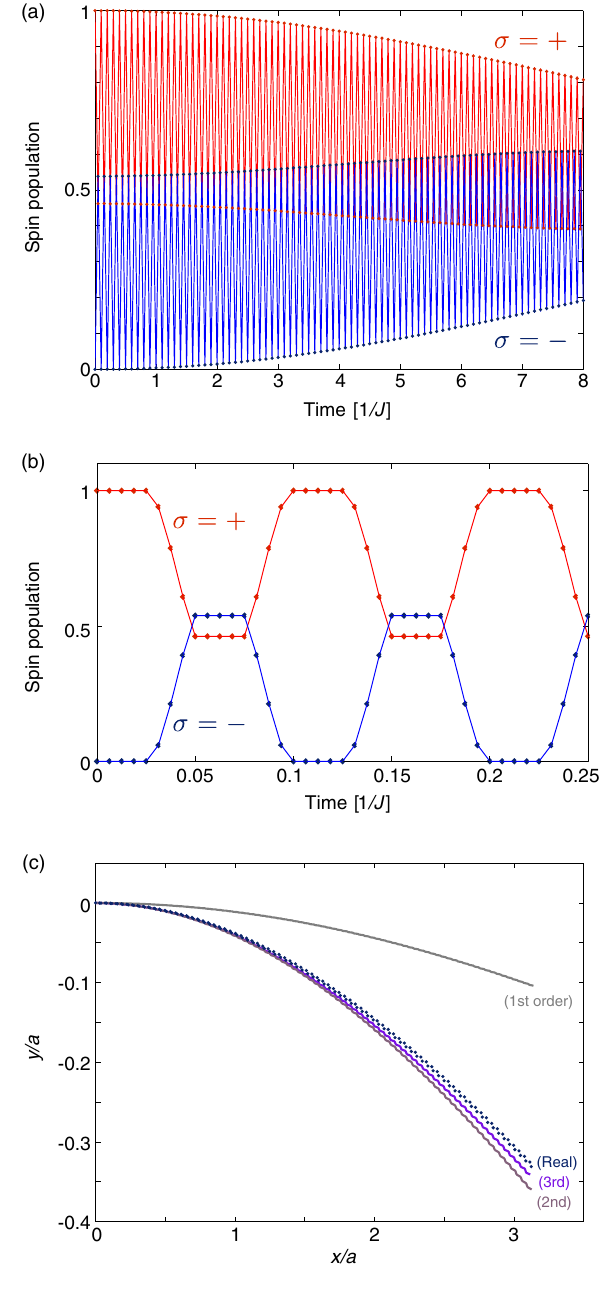
FIG. 4. Thehelical-Rashbascheme:dynamicsofthedrivensystem associatedwiththedrivingsequence(47).Here, κ ¼ 10 J=a and T ¼ 0 . 1 =J .(a)Spinpopulationsasafunctionoftime.Thedynamicsofthe pulsed system (blue and red dots) is compared with the evolution dictated by the evolution operator in Eq. (15) (blue and red lines), ˆ K ˆ H and where ð t Þ are given by Eqs. (17), (48), and (G4). The eff effective and real dynamics are sampled using the time step Δ t ¼ T= 2 . (b) Same as above, but using a time step Δ t ¼ T= 16 to ˆ K highlight the micromotion captured by the kick operator ð t Þ in Eq.(17).(c)Center-of-massdisplacementinthe x - y planeafteratime t ¼ 8 =J . Here, the real trajectory of the driven system (blue dots) is compared with the evolution predicted by the effective Hamiltonian ˆ H atfirst,second,andthirdorder formalism[Eq.(15)],considering eff in 1 = ω . The trajectories are sampled using the time step Δ t ¼ T= 2